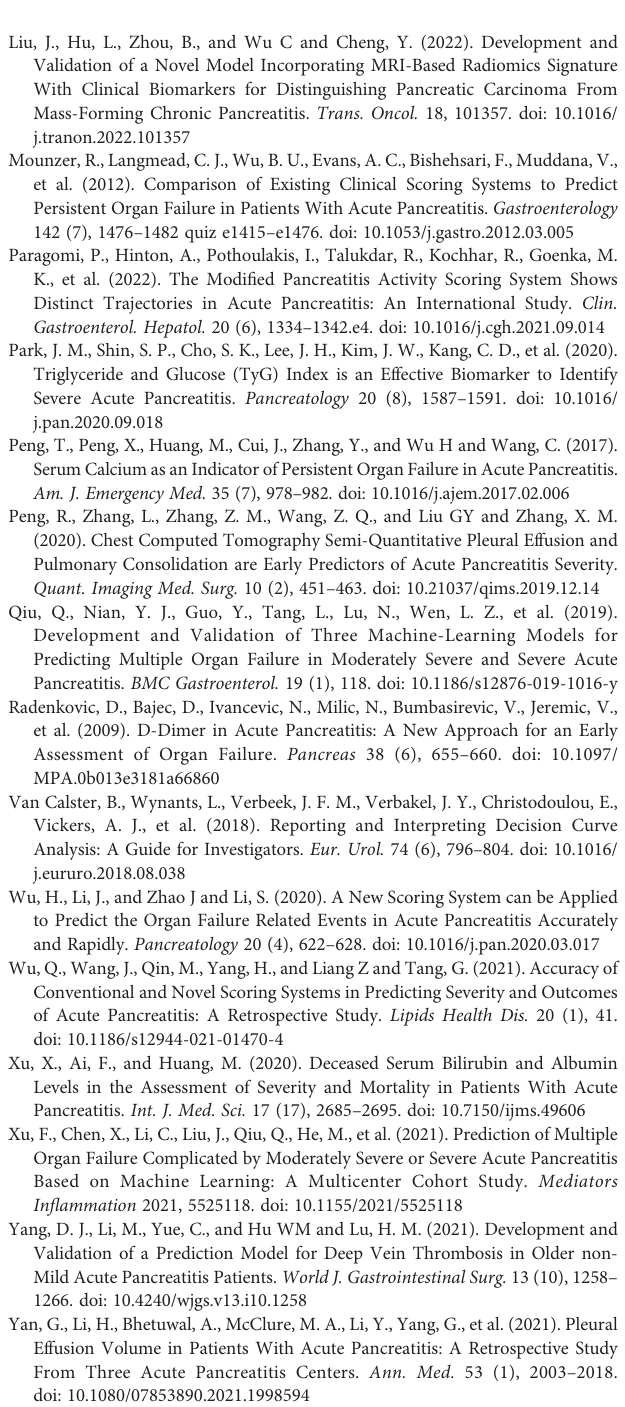
Supplementary Figure 2 | Calibration curve of the LASSO model in the training, validation and test set, with the mean absolute errors being 0.006, 0.033 and 0.036, respectively. The calibration curves demonstrated that the estimated risk using LASSO model was close to the observed risk, indicating a high degree of reliability. Supplementary Figure 3 | Decision curve analysis of the LASSO model in the training, validation and test set. The DCA plots demonstrated that when the